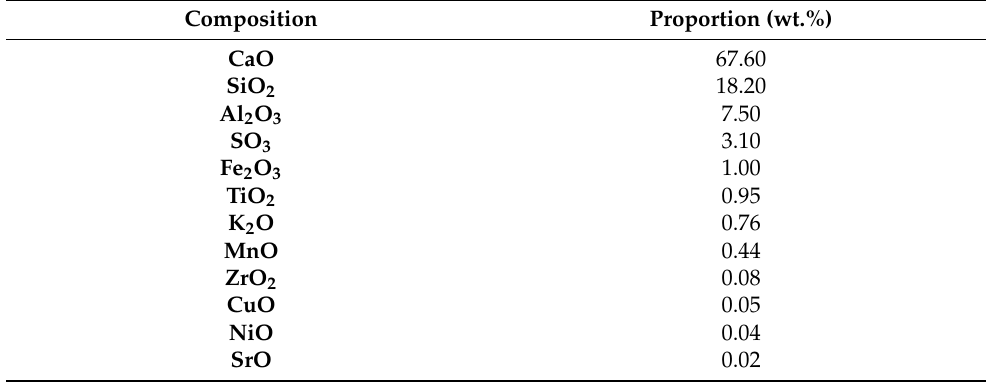
Table 1. Chemical compositions of blast furnace slag measured from X-ray fluorescence